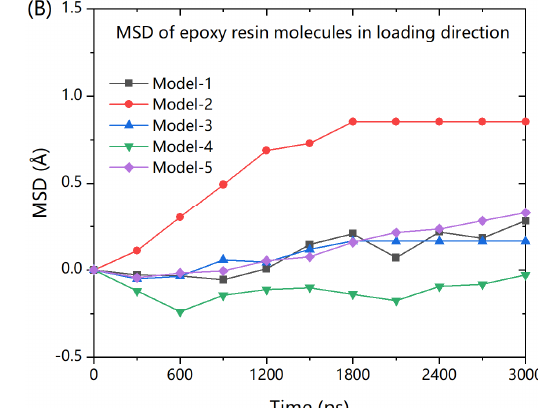
Figure 11. Evolution of the relative radius of gyration during fatigue cyclic loading. Free volume fraction which reflects the porosity in a molecular system was explored to study the diffusion conditions of water molecules. A molecular model consisting of pure epoxy resin was established and same fatigue cyclic loading method was applied to the pure epoxy system as before. The number of representative units here was same as it